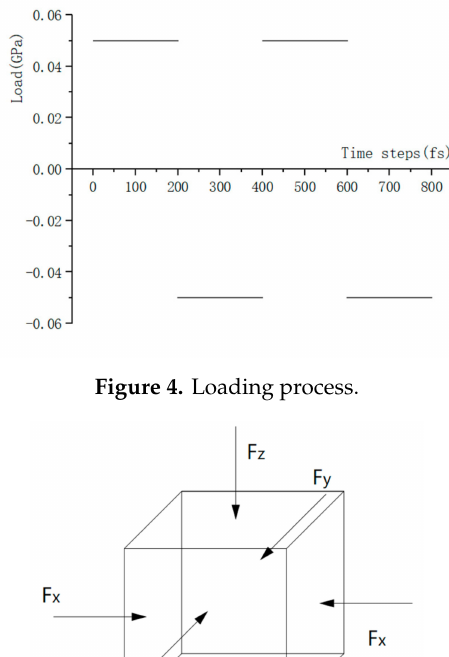
Figure 5. Schematic diagram of pressure